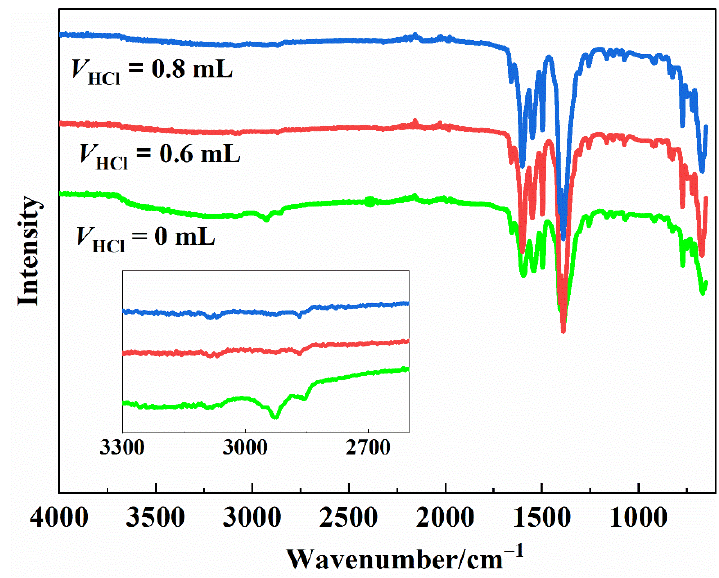
Figure 8. FTIR spectra of UiO − 66 − NO 2 − 25 after soaking in HCl–DMF mixture. UiO-66-NO 2 -X prepared with different amounts of decanoic acid for glucose conver- sion were also analysed and the reaction results are shown in Figure 10. Conversion